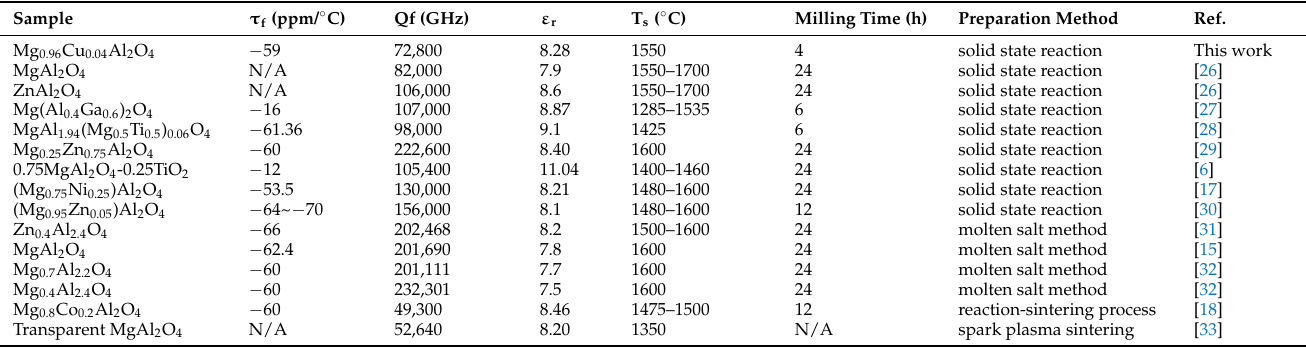
Figure 1. The microwave dielectric properties of Mg 1 − x Cu x Al 2 O 4 ( x = 0–0.2) ceramics sintered at 1450–1600 °C: ( a ) Qf value, ( b ) ε r value, and ( c ) τ f value. Table 1. Microwave dielectric properties and preparation condition of MgAl 2 O 4 -based and ZnAl 2 O 4 ceramics.